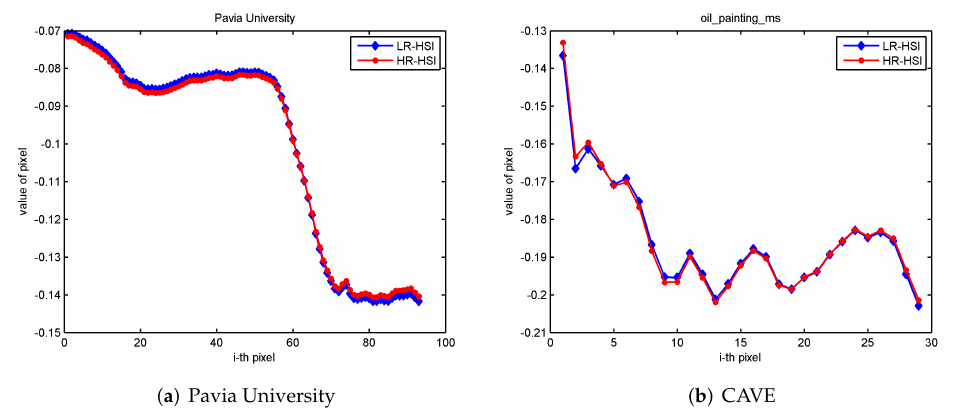
Figure 1. The correlation of the third factor matrix (the first row of matrix) after TMSVD of HR-HSI and HR-MSI.